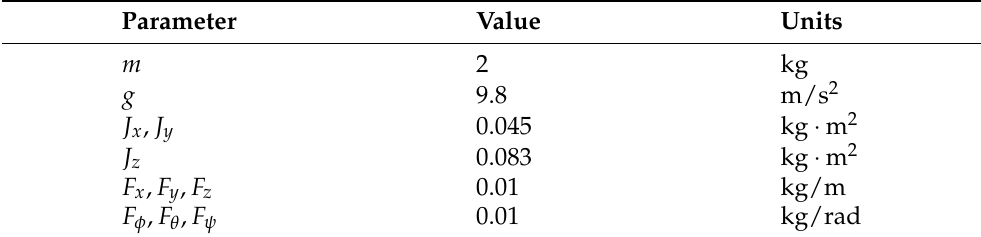
Table 1. The modeled parameters of the